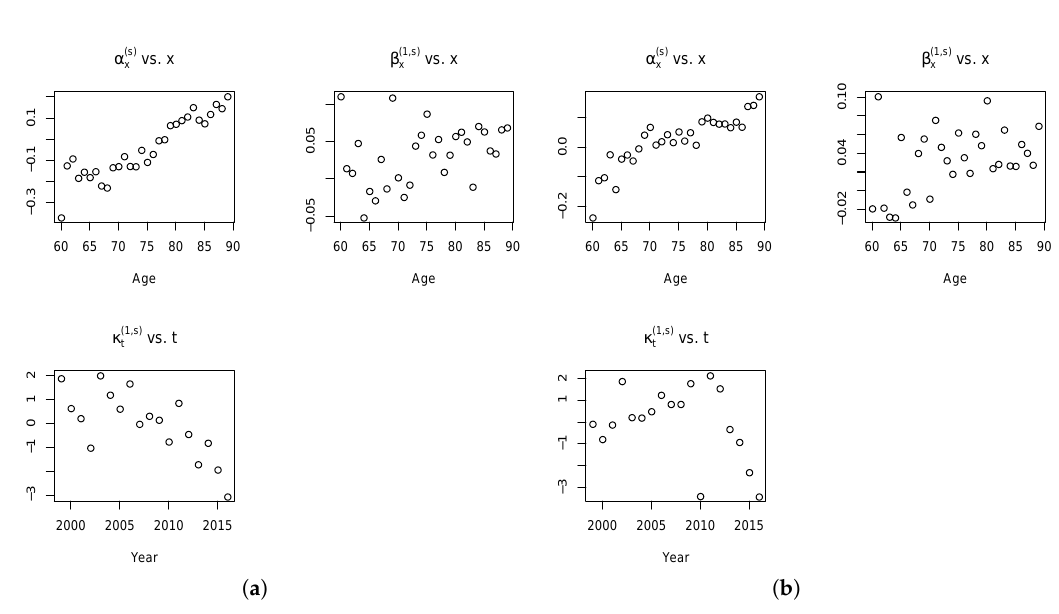
Figure 8. Estimated spread parameters of the Plat–LC model for ( a ) female Maltese population and ( b ) male Maltese